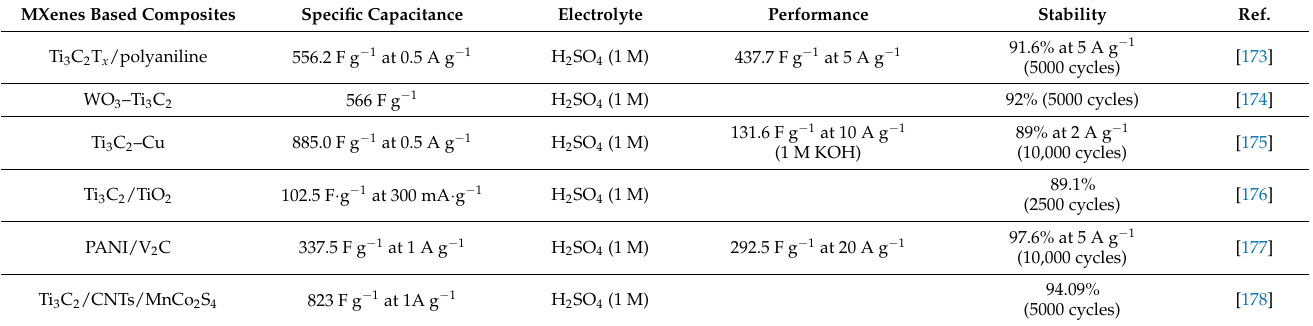
Table 6. Summary of the MXene-based composites for supercapacitor